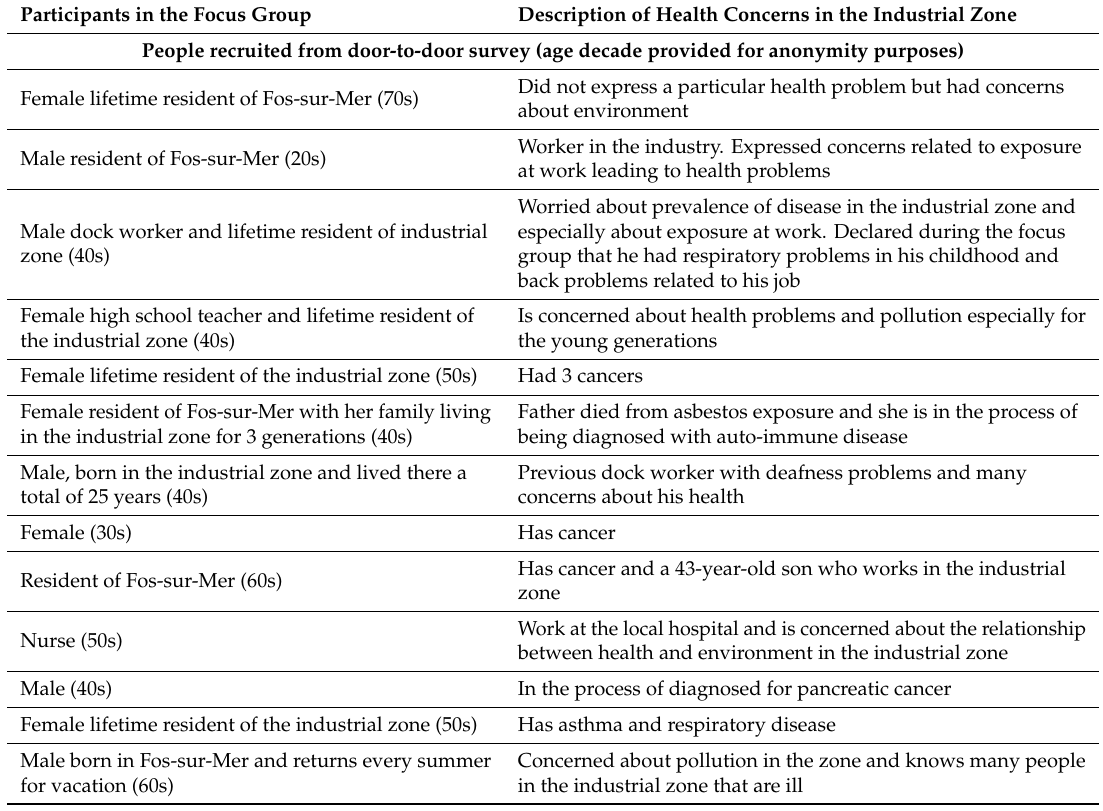
Table 3. Individual profile of some focus group participants in phase 1 of Fos